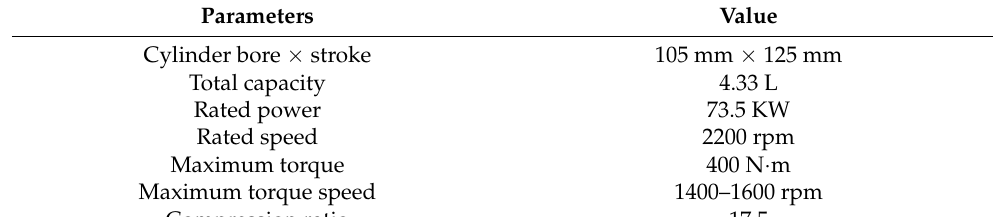
Table 1. Main technical parameters of diesel engine.